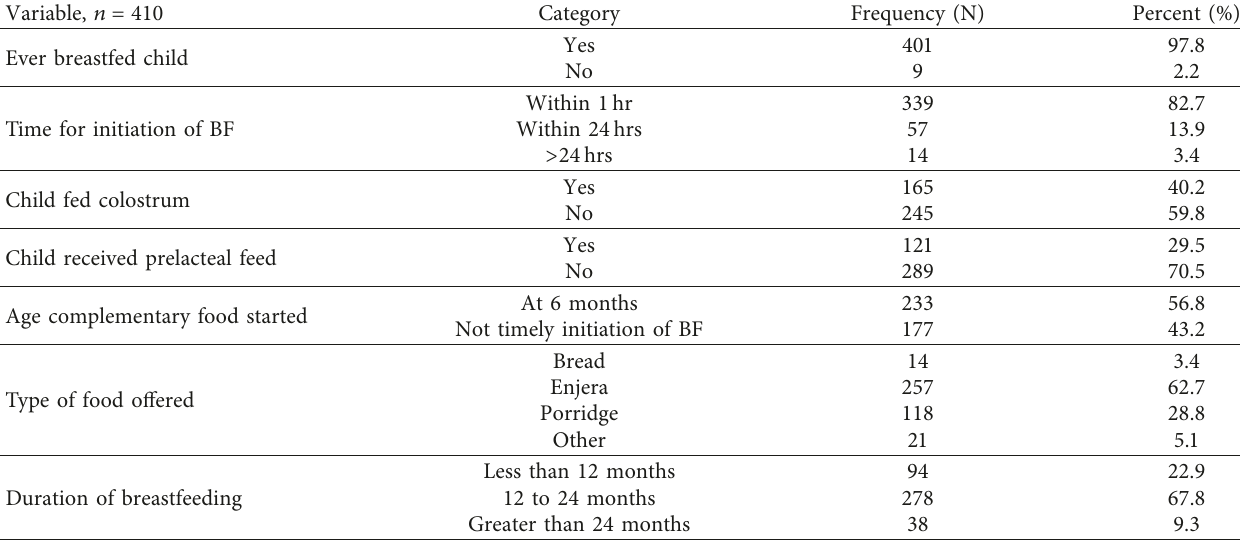
Table 3: Dietary characteristics of children among 6 to 59 months in Merhabete woreda, Ethiopia, 2017, ( n �